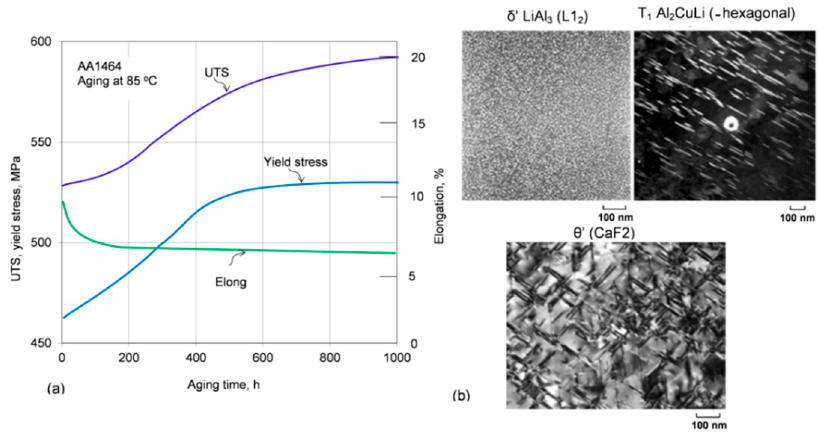
Figure 17. Tensile property change during long-term aging of 2nd generation Al − Li AA1464 alloys at 85 ◦ C, showing an increase in strength and reduction in ductility ( a ) [61] and strengthening precipitates in third generation Al − Li alloys ( b ) [62].